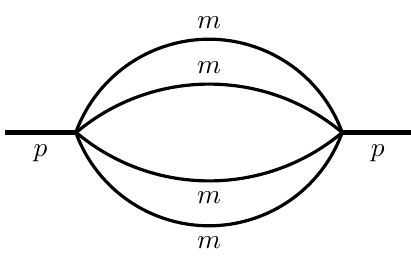
Figure 1 . The three-loop banana